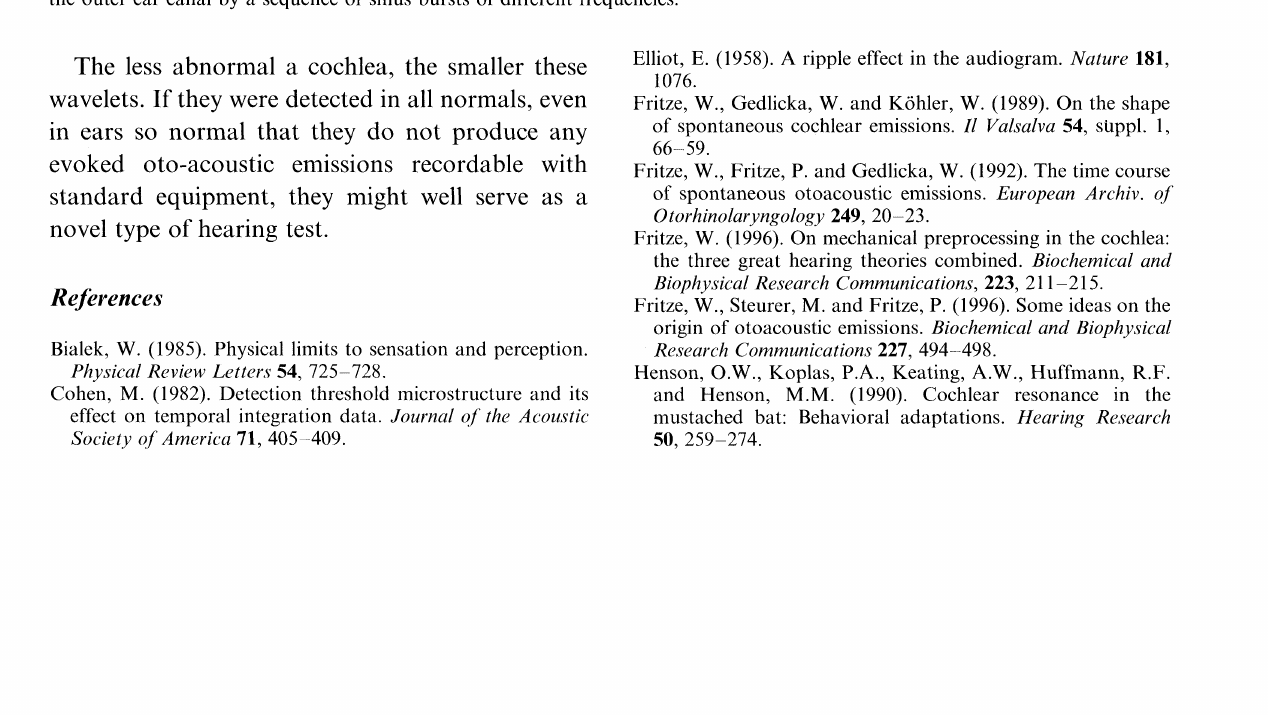
FIGURE 2 Computer simulation of likely OHC vibrations. Horizontal assumed series of 640 units (OHCs), left =apical; vertical time course (from the top down); 2 runs of the algorithm from one line to the next. The algorithm describes the reciprocal effects of coupled and randomly excited pendulums (amplitudes, phases and velocities) with the resonant frequencies rising from left to right. In the image the amplitude is shown (black highest amplitude). Note the clustering of OHCs with a higher vibrating amplitude in terms of the chaos theory. The clusters alternate in a chaotic pattern. This should be reflected in the outer ear canal by a sequence of sinus bursts of different